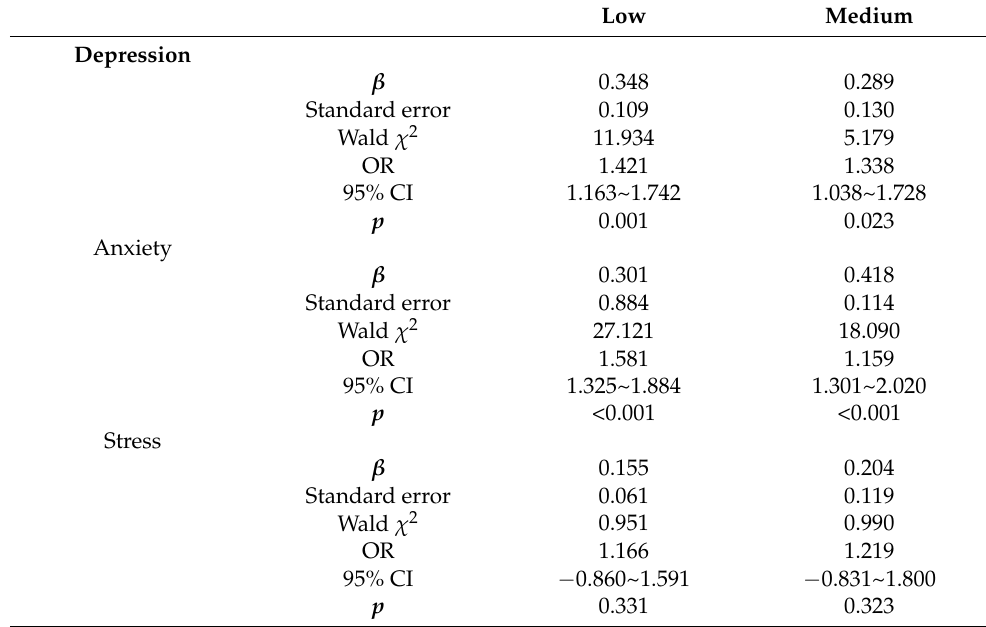
Table 3. Ordinal logistic regression analysis of negative emotions and physical-exercise volume score ( n =